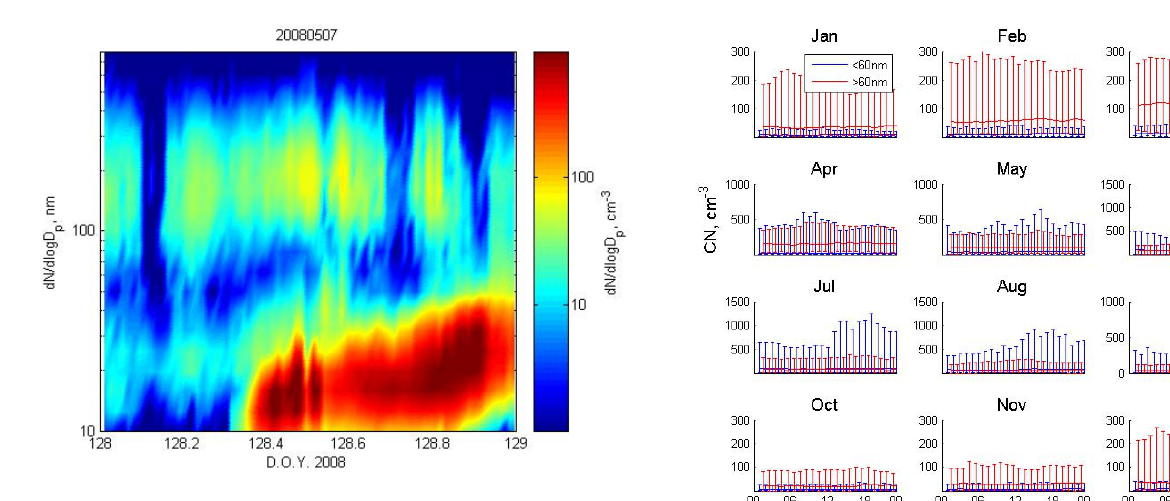
Fig. 9. Example of an Arctic nucleation event as observed 7 May 2008. dN/dlog D p (cm − 3 ) versus decimal day of year (D.O.Y.).